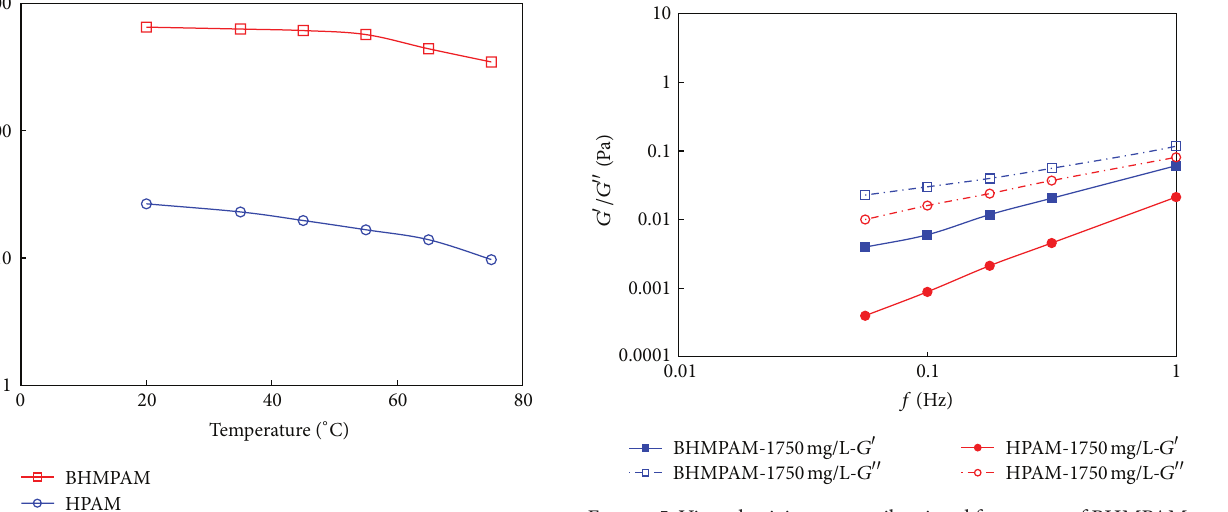
Figure 5: Viscoelasticity versus vibrational frequency of BHMPAM compared to HPAM in synthetic formation water (concentration of both polymers: